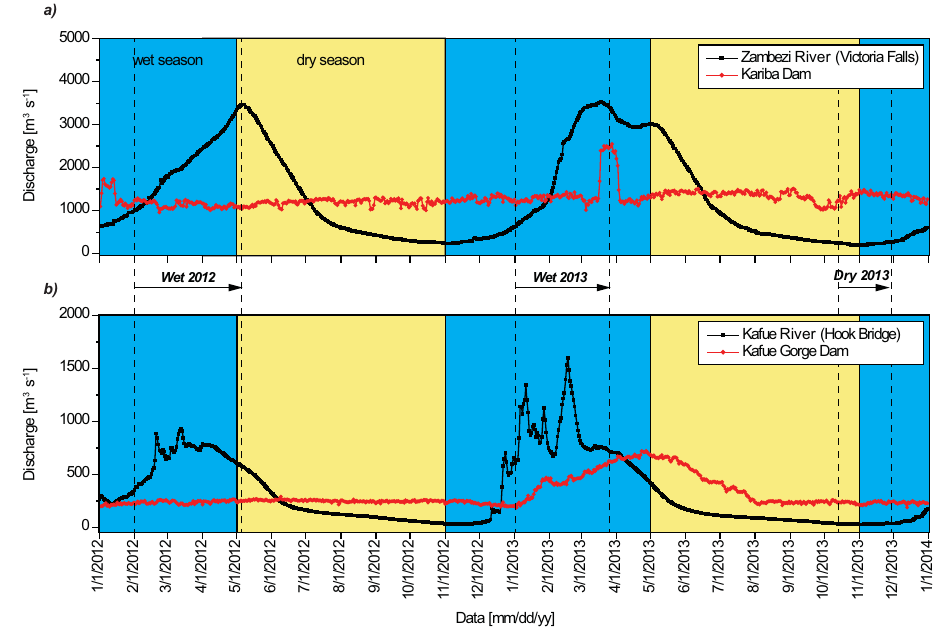
Figure 2. Water discharge for (a) the Zambezi River at Victoria Falls power station and the disturbance of natural flow pattern by dam operation at Kariba Dam, and (b) for the Kafue River at Hook Bridge (upstream of the Itezhi Tezhi Reservoir) and the regulated flow at the Kafue Gorge Dam between January 2012 and January 2014 (data from Zambia Electricity Supply Corporation Limited,